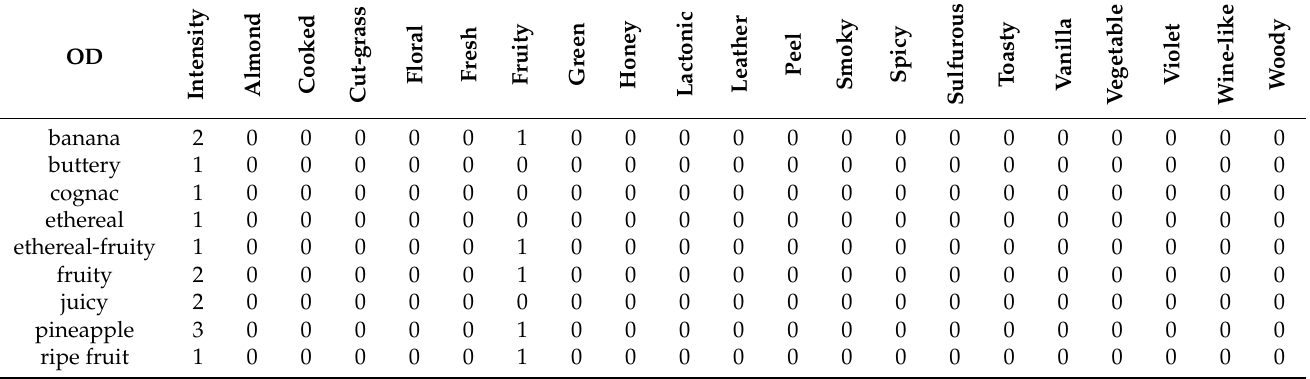
Table 3. Link between the nine ODs of Ethyl butanoate (rows) and the 20 OQs (columns), represented as a binary matrix. The intensity of each OD is specified in the second